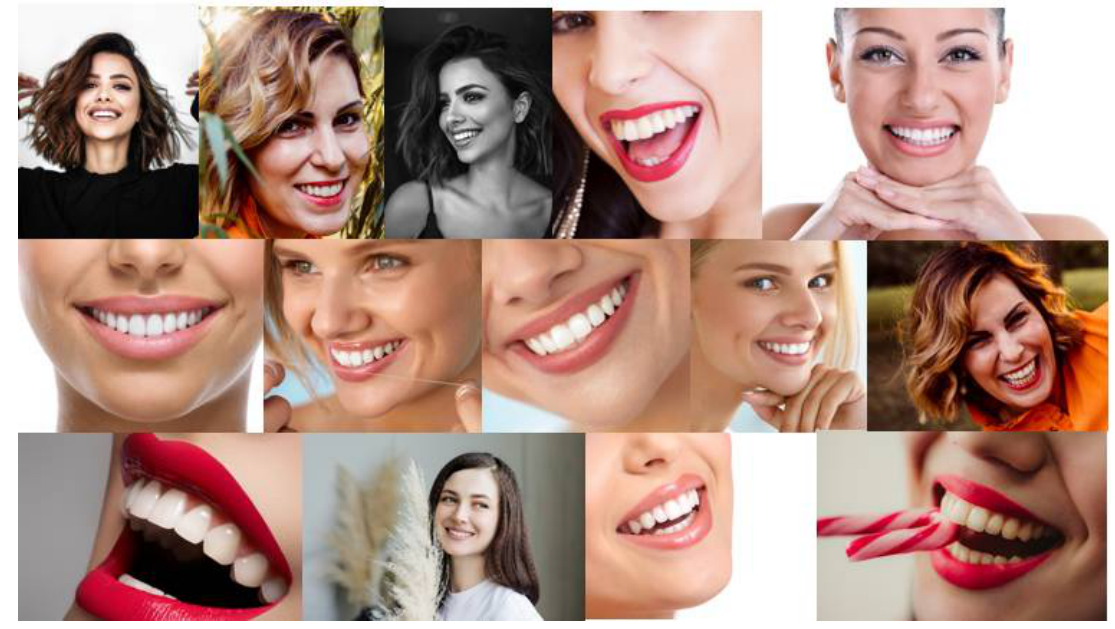
Figure 5. Photographs posted on Instagram .